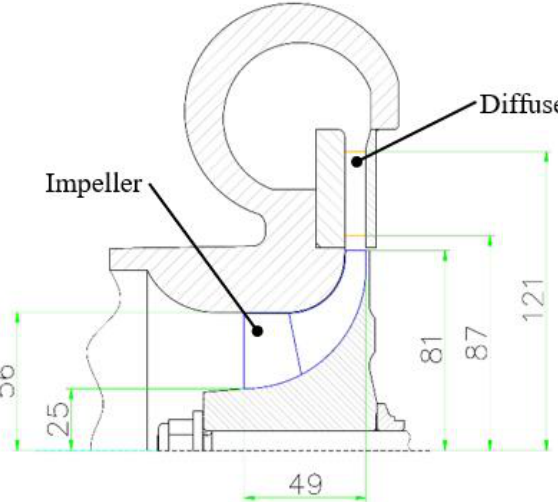
Figure 1. Meridional flow path in the conventional compressor.